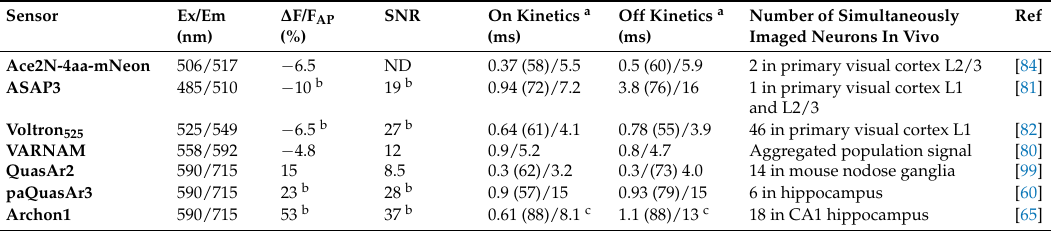
Table 2. Performance of selected genetically-encoded and hybrid fluorescent voltage sensors.